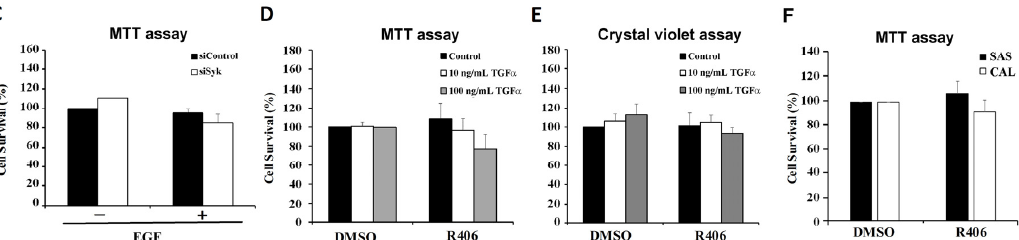
Figure 4. Syk is not involved in the proliferation and viability of SCC cells. ( A ) Effects of R406 (1 μ M) with or without co-treatment with EGF (50 ng/mL) on A431 cell proliferation for 16 and 24 h were analysed by BrdU assay. ( B ) Effects of R406 (1 μ M) with or without co-treatment with EGF (100 ng/mL) on A431 cell viability for 24 h analysed by MTT, ATP, and crystal violet assays. ( C ) Effects of Syk siRNA with or without EGF (50 ng/mL) for 24 h on A431 cell viability analysed by an MTT assay. ( D , E ) Cell viability of A431 cells after treatment with R406 (1 μ M) with or without co-treatment with TGF α (10 or 100 ng/mL) for 24 h analysed by MTT and crystal violet assays. ( F ) Viability of SAS and CAL27 cells treated with R406 for 24 h determined by MTT assay. Data are expressed as the mean ± S.E.M. from three independent experiments.